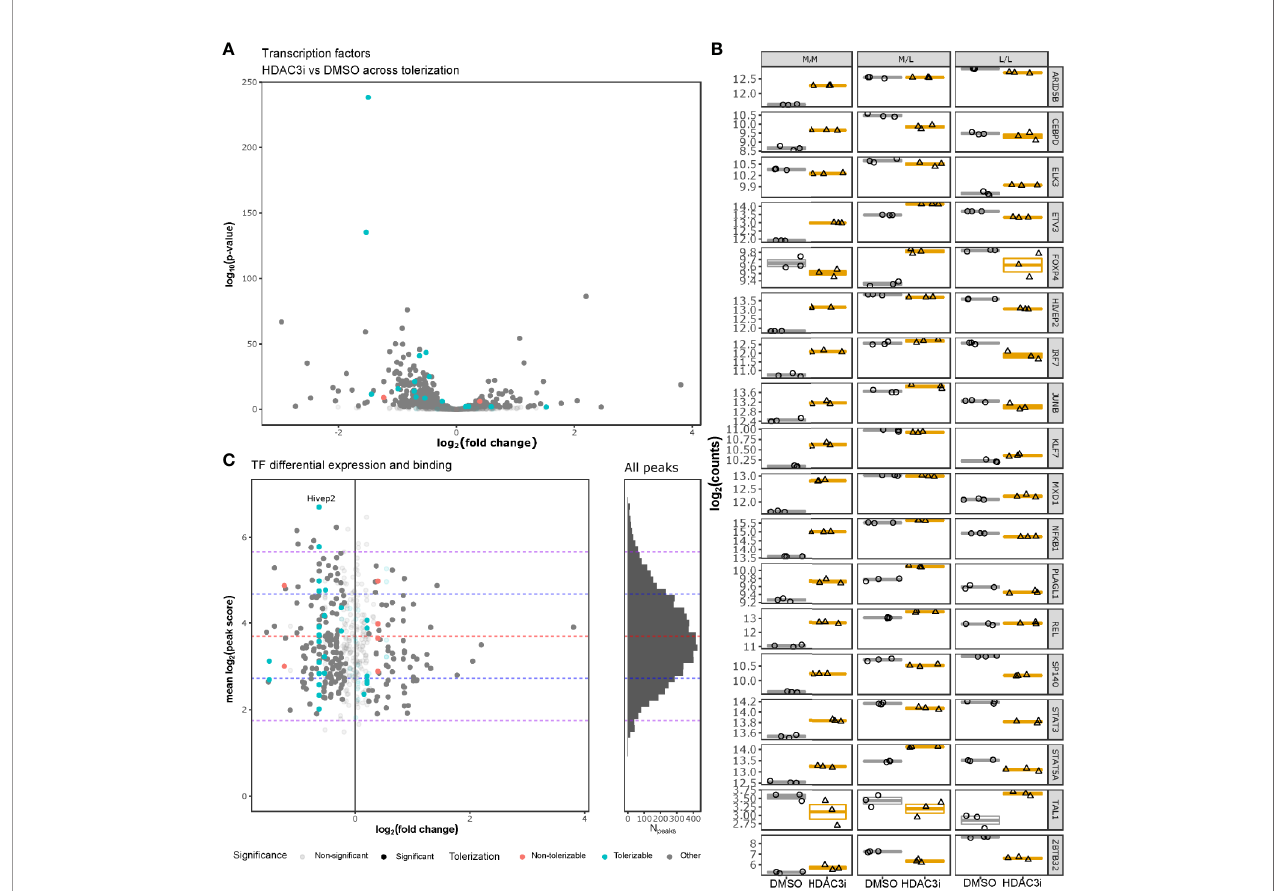
FIGURE 6 | HDAC3i-treatment effect on transcription factors. Gene expression of human tolerizable TFs across the non-tolerized and tolerized states was interrogated and compared with HADC3 binding in mice macrophages. (A) Gene expression of tolerizable human TFs, obtained from Foster et al., 2007 and Lambert et al., 2018, respectively, were presented as a volcano plot with the log 2 fold-change on the x-axis and the – log 10 ( p -value) on the y-axis. (B) The expression in log 2 (counts) on the y-axis of the signi fi cantly differentially expressed TFs ( ARID5B, CEBPD, ELK3, ETV3, FOXP4, HIVEP2, IRF7, JUNB, KLF7, MXD1, NFKB1, PLAGL1, REL, SP140, STAT3, STAT5A, TAL1 and ZBTB32 ) for M/M, M/L and L/L macrophages, pretreated either with DMSO or HDAC3i. (C) Overlap of the differentially expressed tolerizable TFs with the HDAC3-bound TFs in mouse BMDMs as obtained from GSE106701 samples GSM2845618 and GSM2845619. The x-axis represents the log 2 (fold change), while the y-axis represents the mean log 2 (MACS peak score). Histogram on the right represents the mean log 2 (MACS peak score) distribution (y-axis) for all the HDAC3-binding regions reported by Czimmerer et al. x-axis represents number of peaks (N peaks ). The red, blue and purple dashed horizontal lines represent the mean, fi rst and second standard deviations,